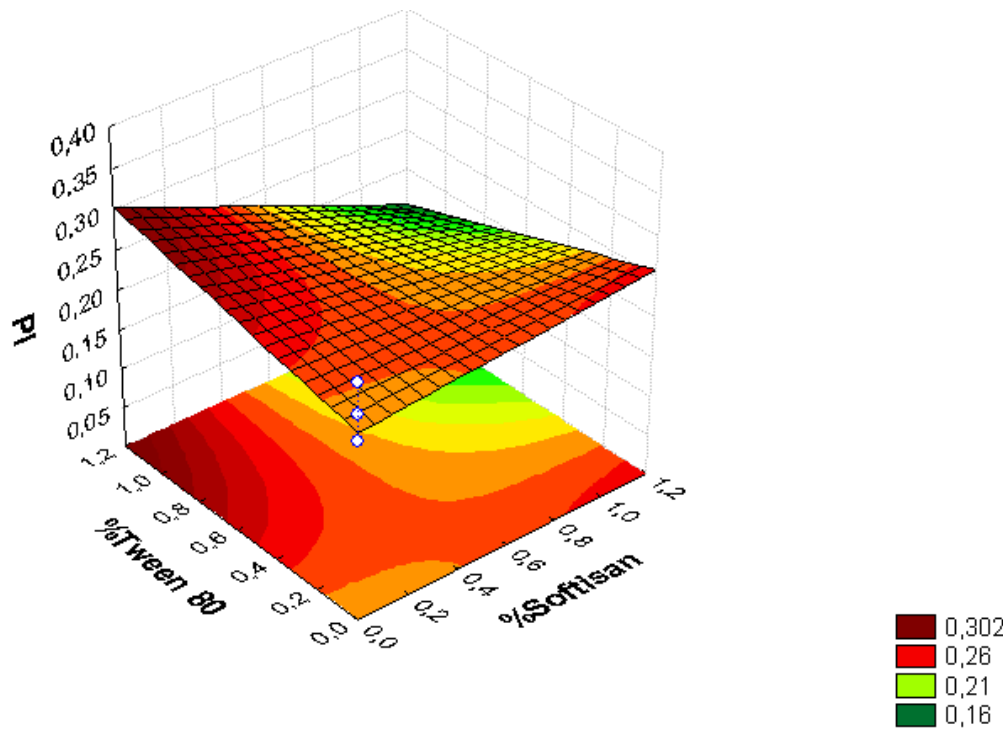
Figure 2. Surface response chart of the effect of the % of Tween ® 80 and SOFTISAN ® 649 on PI.